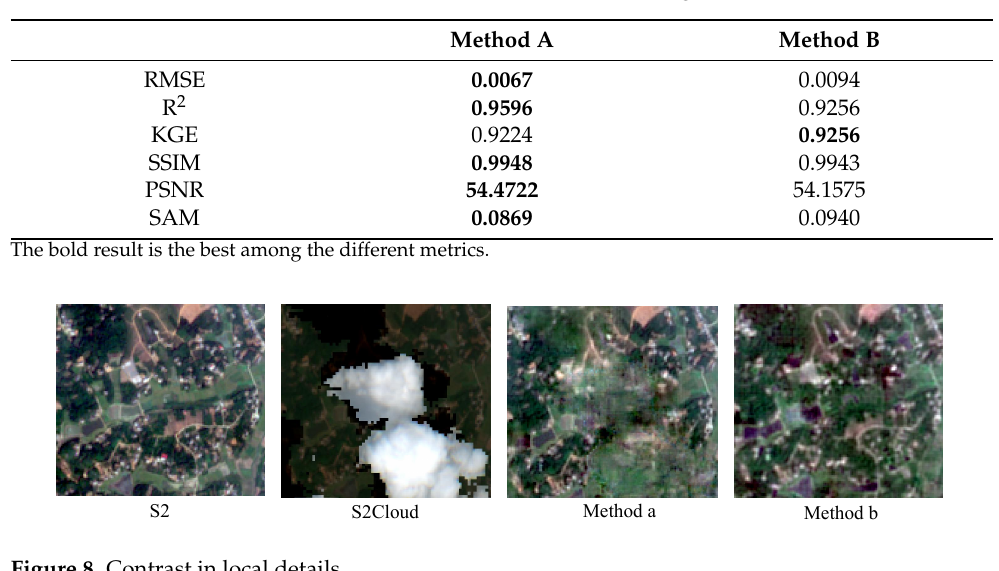
Figure 8. Contrast in local